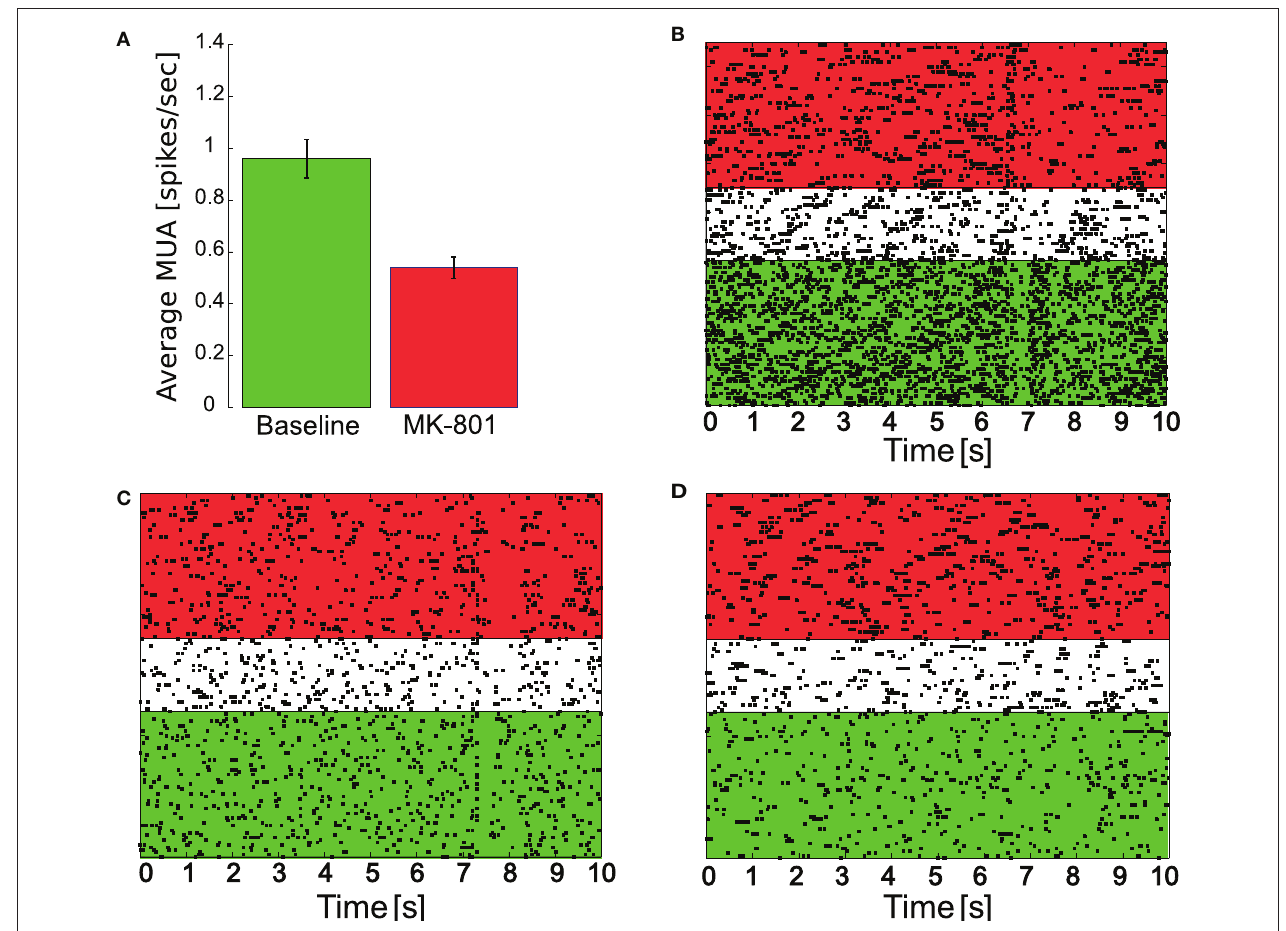
Figure 4 | Change of cellular activity in response to MK-801 administration. Multi‑unit activity (A) , reflecting an average change of spiking activity showed a significant ( p = 0.0128) decrease (mean ± SEM shown) following drug treatment (0.05 mg/kg MK‑801, i.v.), however, individual cells with decreased (B) ,